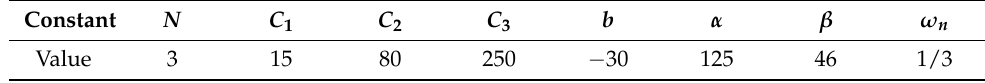
Table 1. The parameter table of